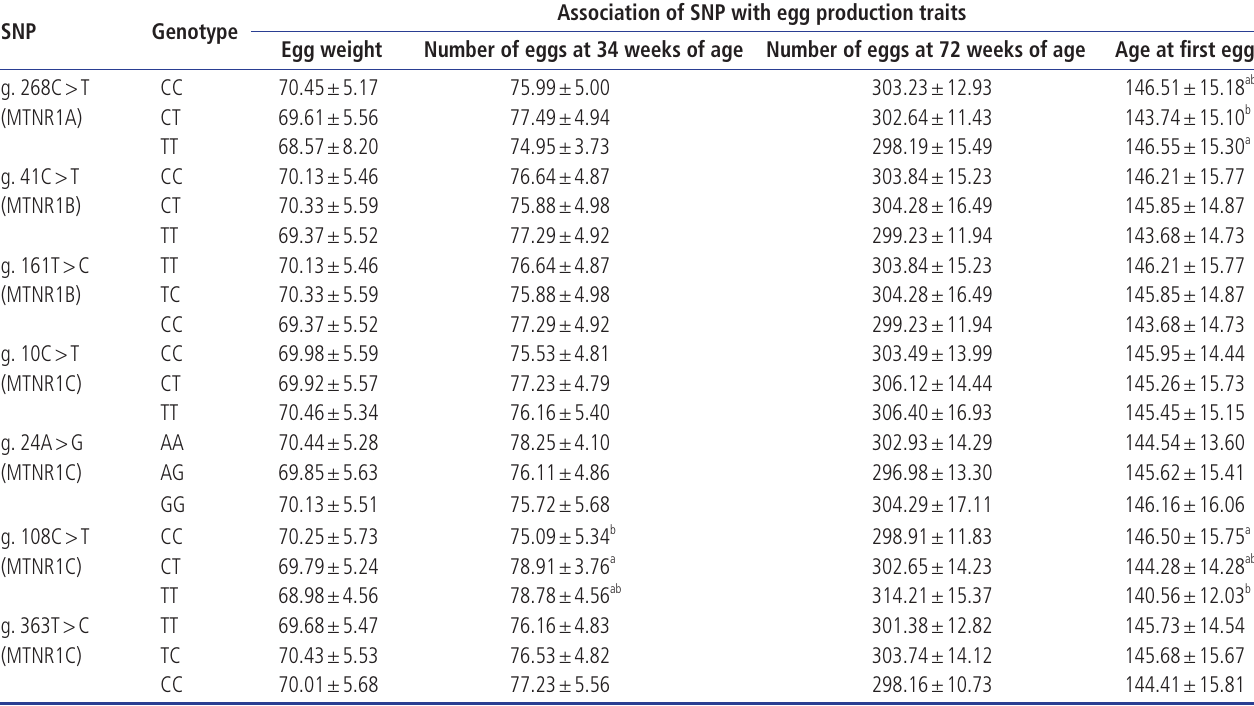
Table 3. Association between polymorphisms in MTNR1A, MTNR1B, and MTNR1C genes and egg production traits in Shaoxing ducks